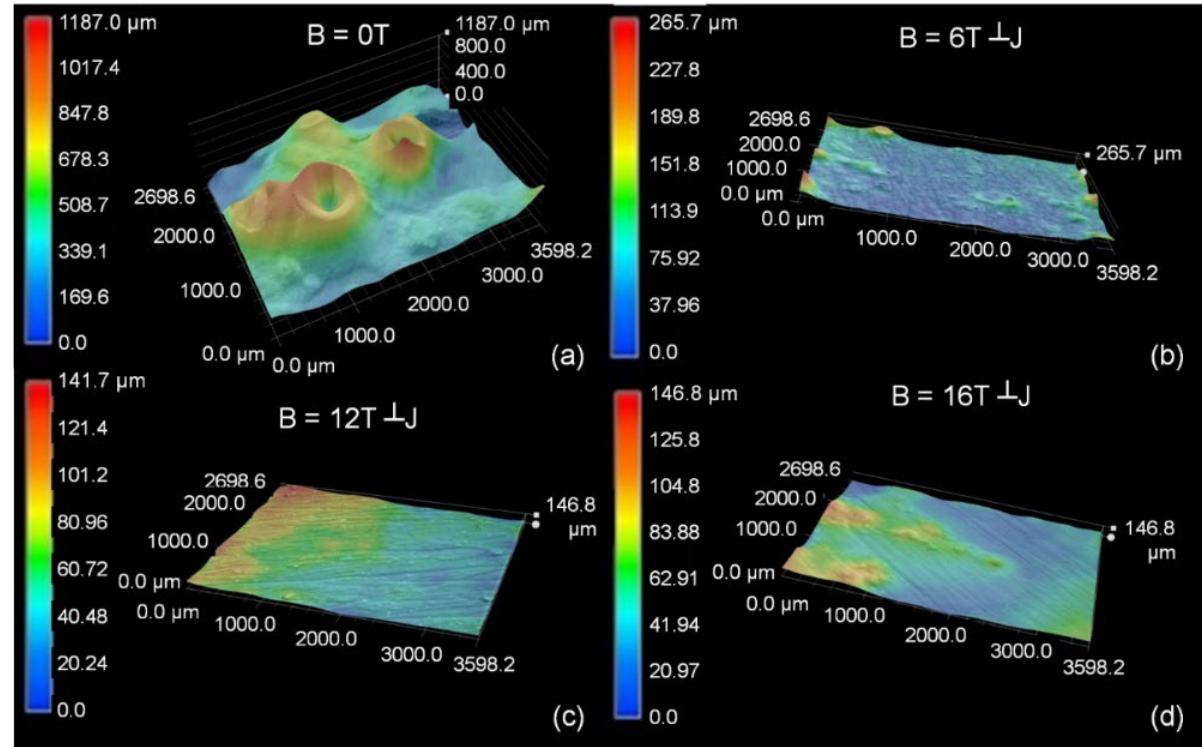
Figure 1. The schematic experimental apparatus.